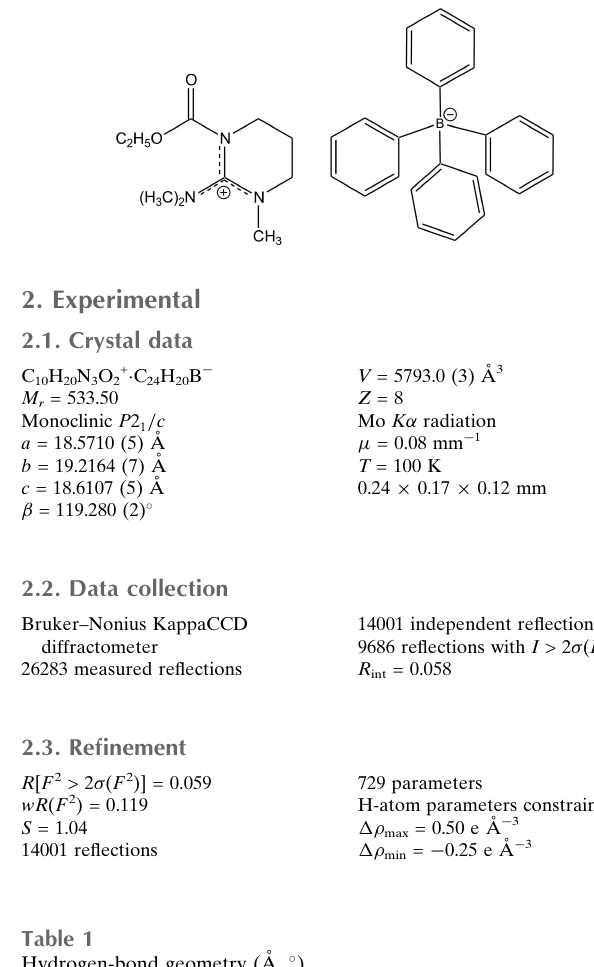
Hydrogen-bond geometry (A˚ , (cid:4)